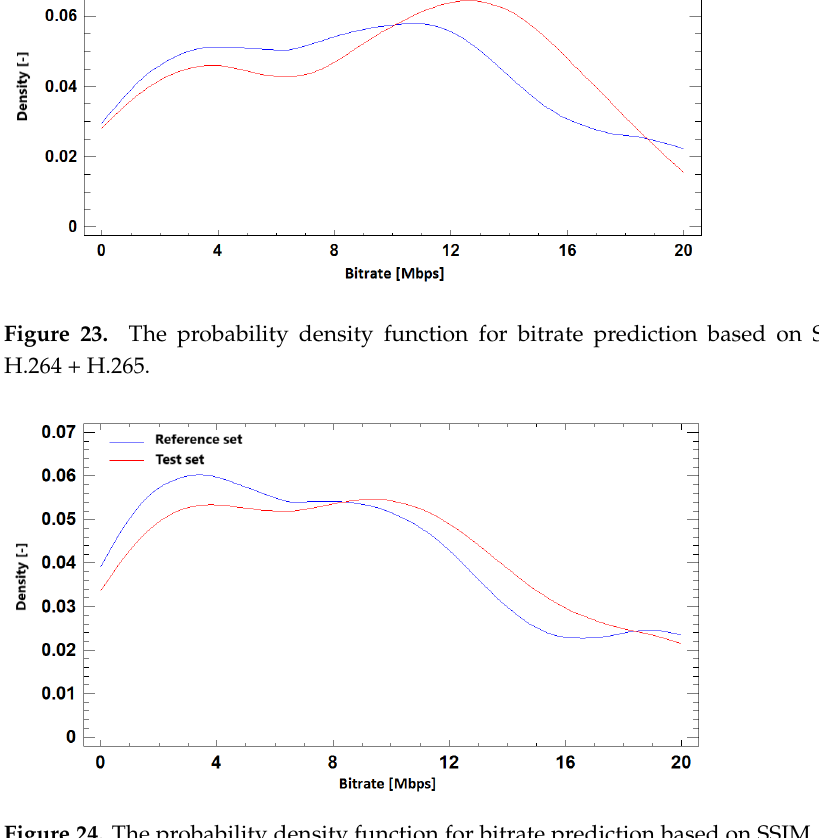
Figure 24. The probability density function for bitrate prediction based on SSIM, Full HD + Ultra HD , H.264 + H.265.